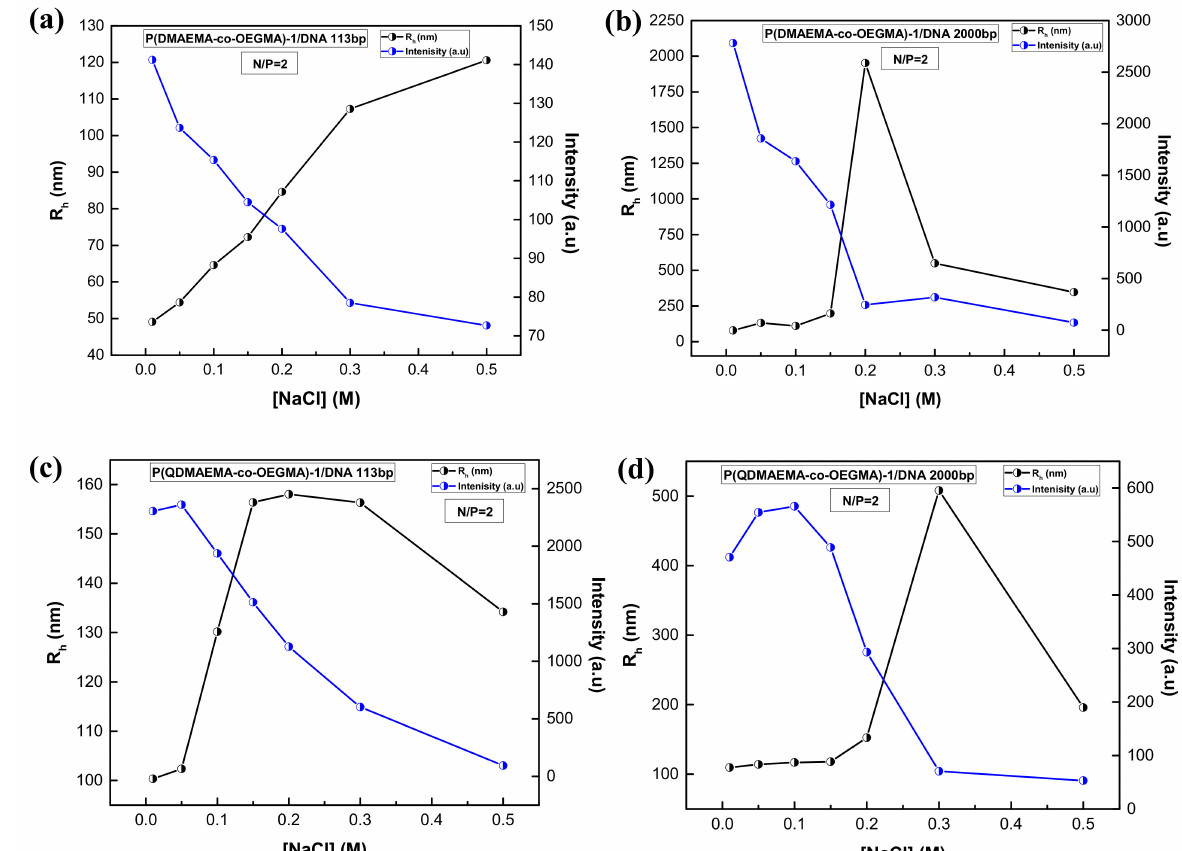
Figure 10. Hydrodynamic radius (R h ) and scattered light intensity as a function of ionic strength for ( a ) P(DMAEMA-co-OEGMA)-1/DNA 113 bp, ( b ) P(DMAEMA-co-OEGMA)-1/DNA 2000 bp, ( c ) P(QDMAEMA-co-OEGMA)-1/DNA 113 bp, and ( d ) P(QDMAEMA-co-OEGMA)-1/DNA 2000 bp polyplexes at N/P =